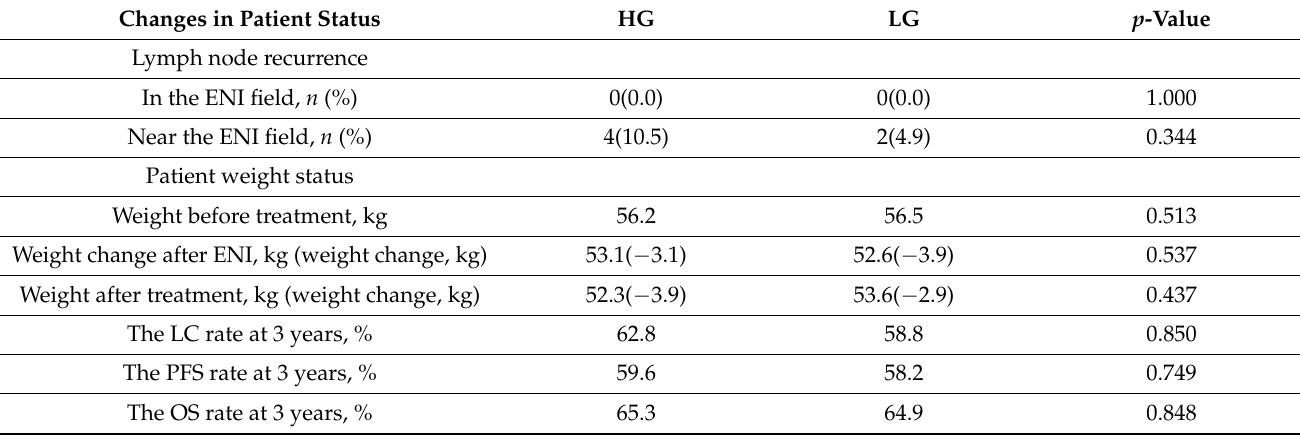
Table 3. Changes in patient status with treatment ( n = 79).